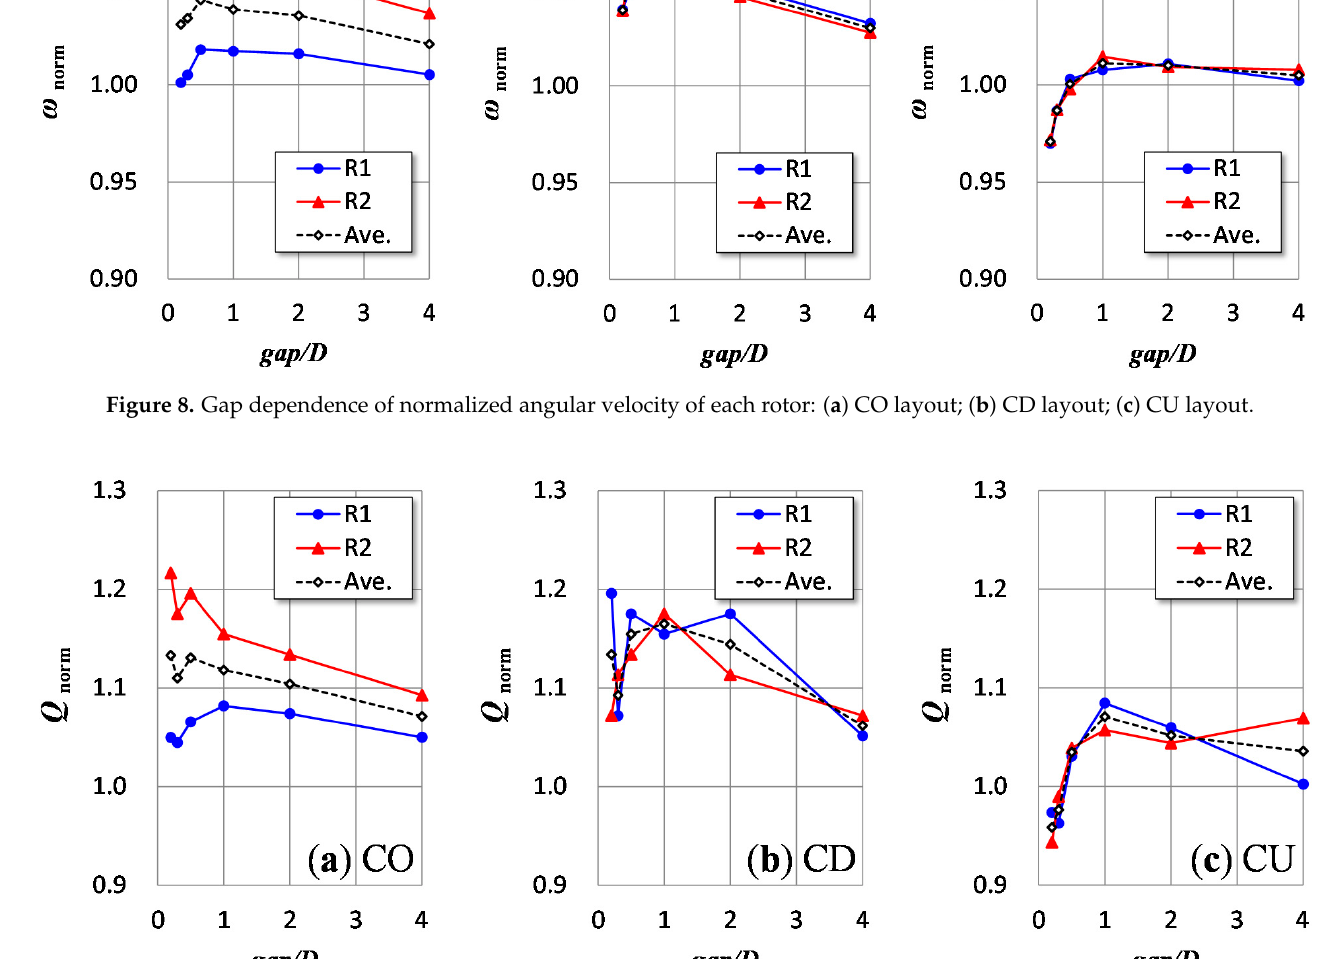
Figure 9. Gap dependence of normalized torque of each rotor: ( a ) CO layout; ( b ) CD layout; ( c ) CU layout.